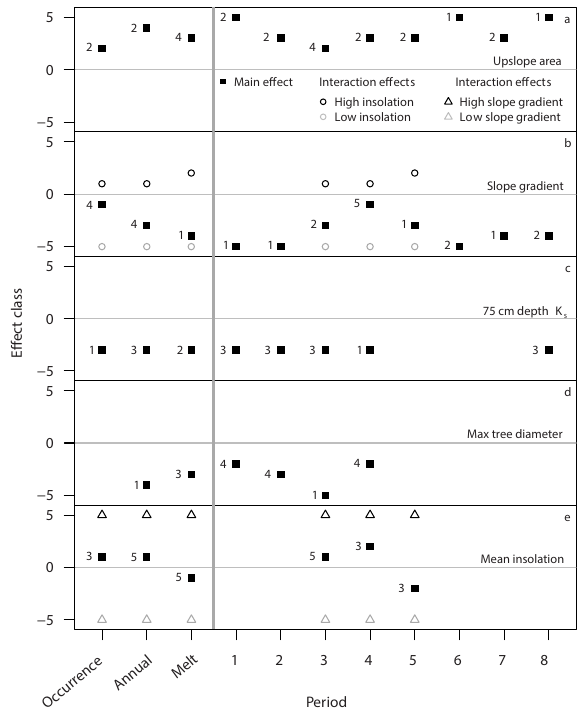
Figure 5. Effect class, direction of the effect (positive or negative), and effect rank (indicated numerically to the left of the data point) for the variables in the logistic regression models predicting ground- water response duration. For each effect class, the strength of the ef- fect was (1) 1–5, (2) 5–10, (3) 10–50, (4) 50–100, and (5) > 100, as outlined in Table 5. The effects were calculated as the exponential of the following product: the coefficient for the predictor variable multiplied by the range in the data between the 25th and 75th per- centile values for the variable. Interaction terms were ignored for calculating main effects. For calculating interaction effects, the cor- responding interaction variables were held at their respective mini- mum or maximum values. The streamflow periods are (1) fall tran- sition, (2) winter low-flow, (3) early-melt transition, (4) rising limb, (5) peak-flow, (6) falling limb, (7) post-melt transition, and (8) sum- mer low-flow (see Sect. 2.3.3 and Fig. 2 for